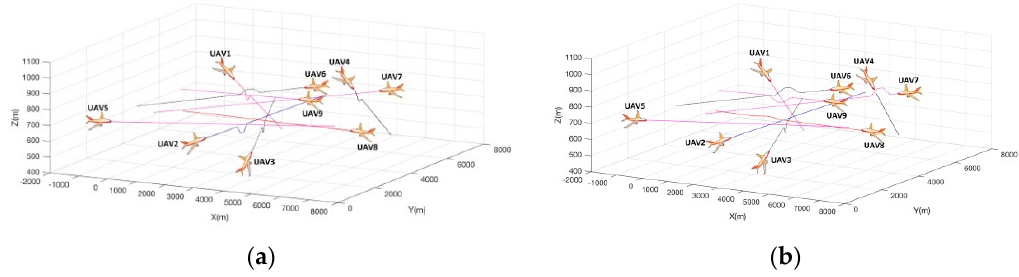
Figure 4. Trajectory ( a ) with key node selecting based on degree and ( b ) with key node selecting based on the node contraction method.